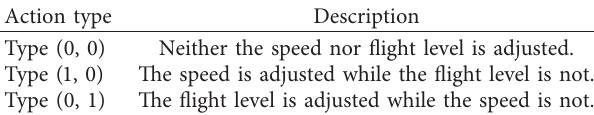
Table 1: Different types of action at each